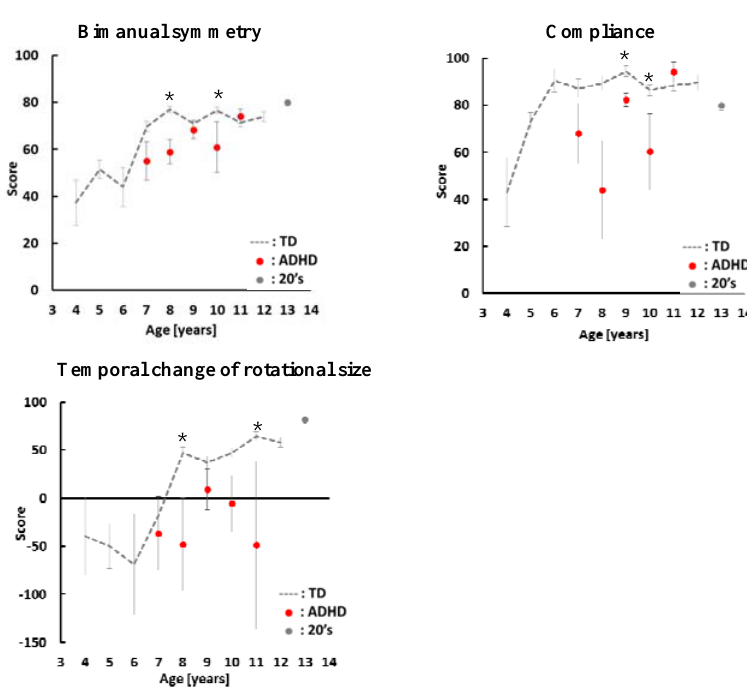
Figure 3. Average scores and standard errors in the imitative motor task. The average score of children with ADHD is indicated by the red dots. The gray dashed line shows the average score of TD children. Gray dots show the average scores of adults aged 21–29 years old. *: p <